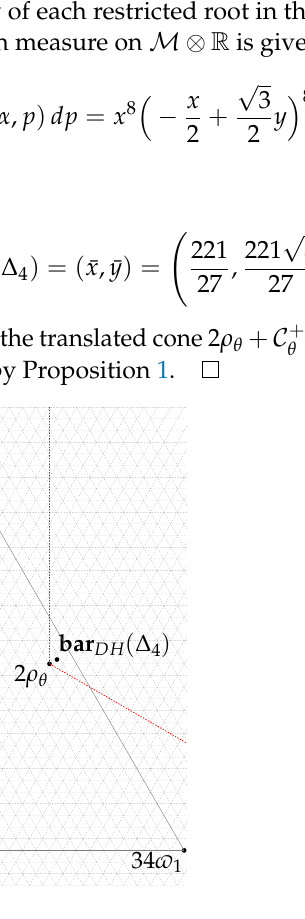
Figure 4. ∆ 4 = ∆ ( X 4 , K − 1